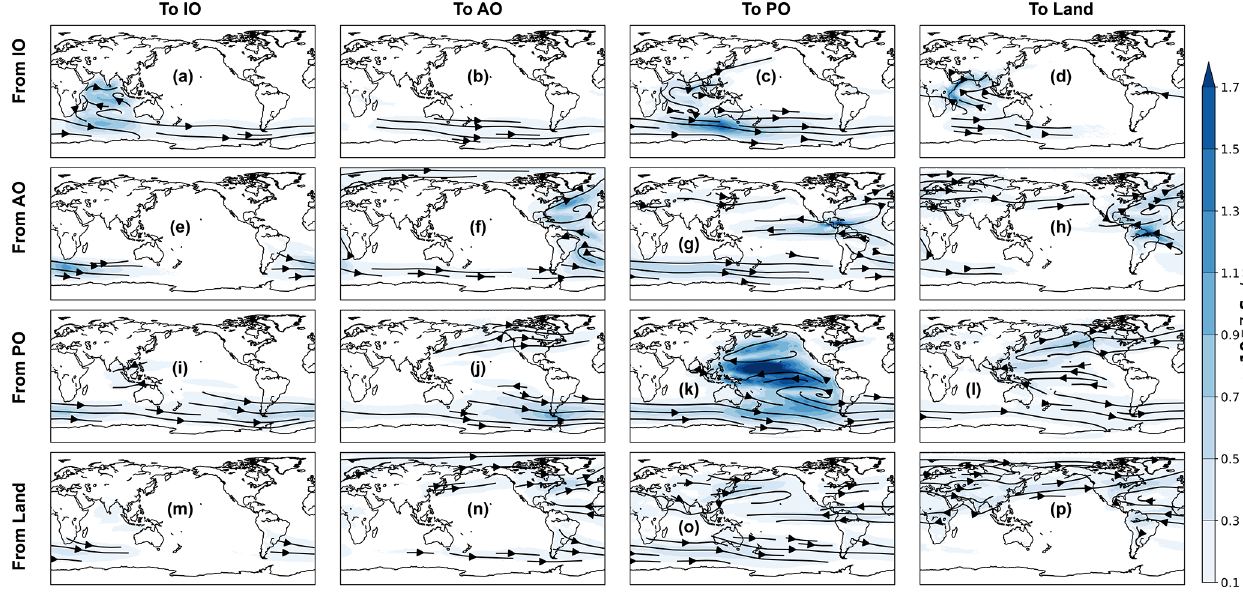
Figure 5. The vertically integrated horizontal water flux (shaded; Svm − 1 ) within and between the ocean basins and land. This has been achieved by grouping the atmospheric water trajectories according to their starting and ending locations. The starting and ending points of the Lagrangian trajectories are defined as per the sectors presented in Fig. 1. The flux directions are given by the black lines.